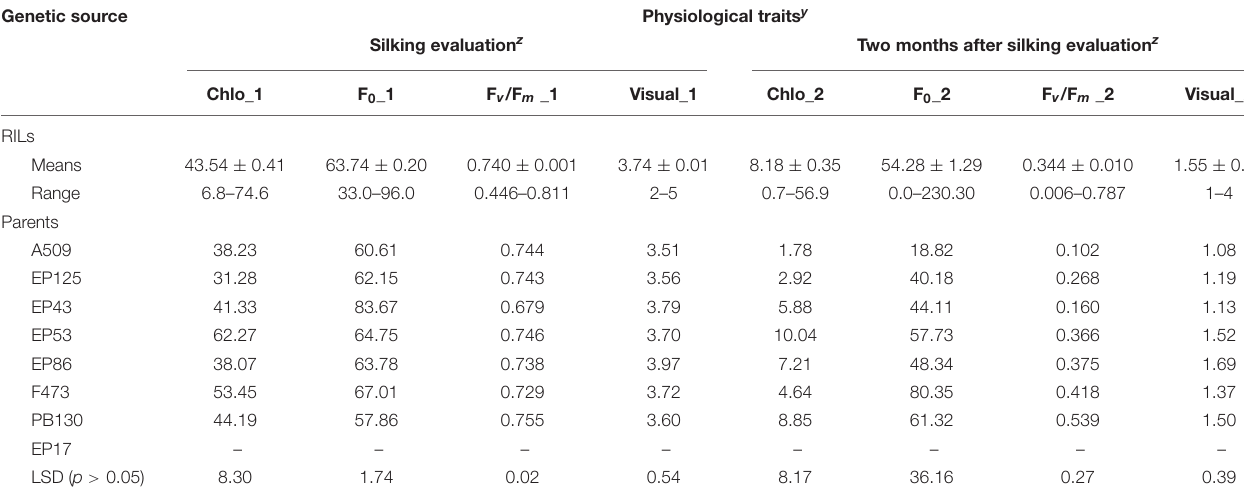
TABLE 1 | Averages values of 465 RIL and means of founder parents for three physiological traits and senescence visual scores evaluated at two phenological stages in the MAGIC population across two environments in Pontevedra,